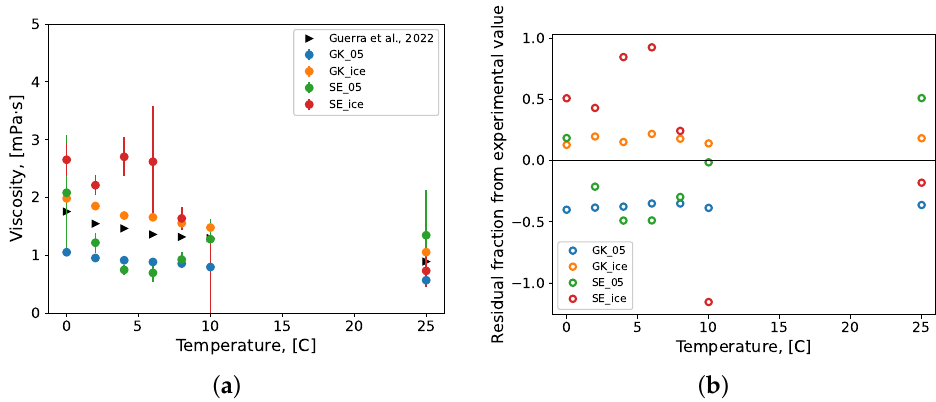
Figure 5. The ( a ) viscosity of pure water systems and ( b ) fractional residual difference between the MD prediction and experimental value. Repeated simulation produced samples of each condition’s prediction value of size n = 10; theses samples were bootstrapped with replacement ( n = 10,000) to calculate the mean values which are presented here with their standard error bars. Experimental values were collected and presented elsewhere by Guerra et al. [30]. GK: Green–Kubo formulation; SE: Stokes–Einstein formulation, 05: TIP4P/200; ice: